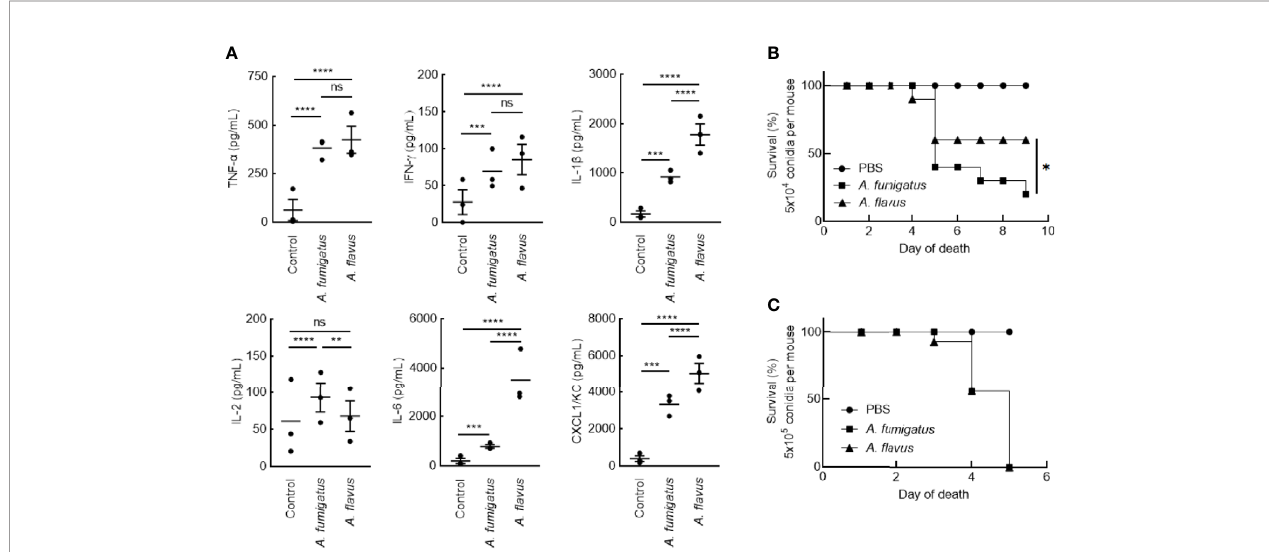
FIGURE 1 | (A) Lung-cytokine analyses upon infecting mice with Aspergillus conidia. Immunocompetent mice were infected intranasally with A. fumigatus or A. fl avus conidia (1x10 7 /mouse; control mice were injected with PBS). Mice were sacri fi ced after 6 h, their lungs were collected, homogenized and the cytokines in the supernatant were estimated by ELISA (Mean ± standard deviation; ns – not signi fi cant, **p < 0.05, ***p < 0.005 and ****p < 0.0005). (B, C) Survival of mice infected with conidia. BALB/c mice were immunosuppressed by intraperitoneal injections of cyclophosphamide (200 mg/kg) on day -4 and day -1. On day 0, prior to the infection, each mouse was anesthetized by intramuscular injection of 10 mg/mL ketamine and 10 mg/ml xylazine (150 m l). Following, each mouse was intranasally inoculated with (B) 5x10 4 or (C) 5x10 5 conidia; control mice received 25 m l PBS-Tween. Upon 5x10 4 conidial inoculation, A. fumigatus infected mice showed signi fi cantly lower survival rate (20%) compared to A. fl avus -infected mice (60%) (*p <